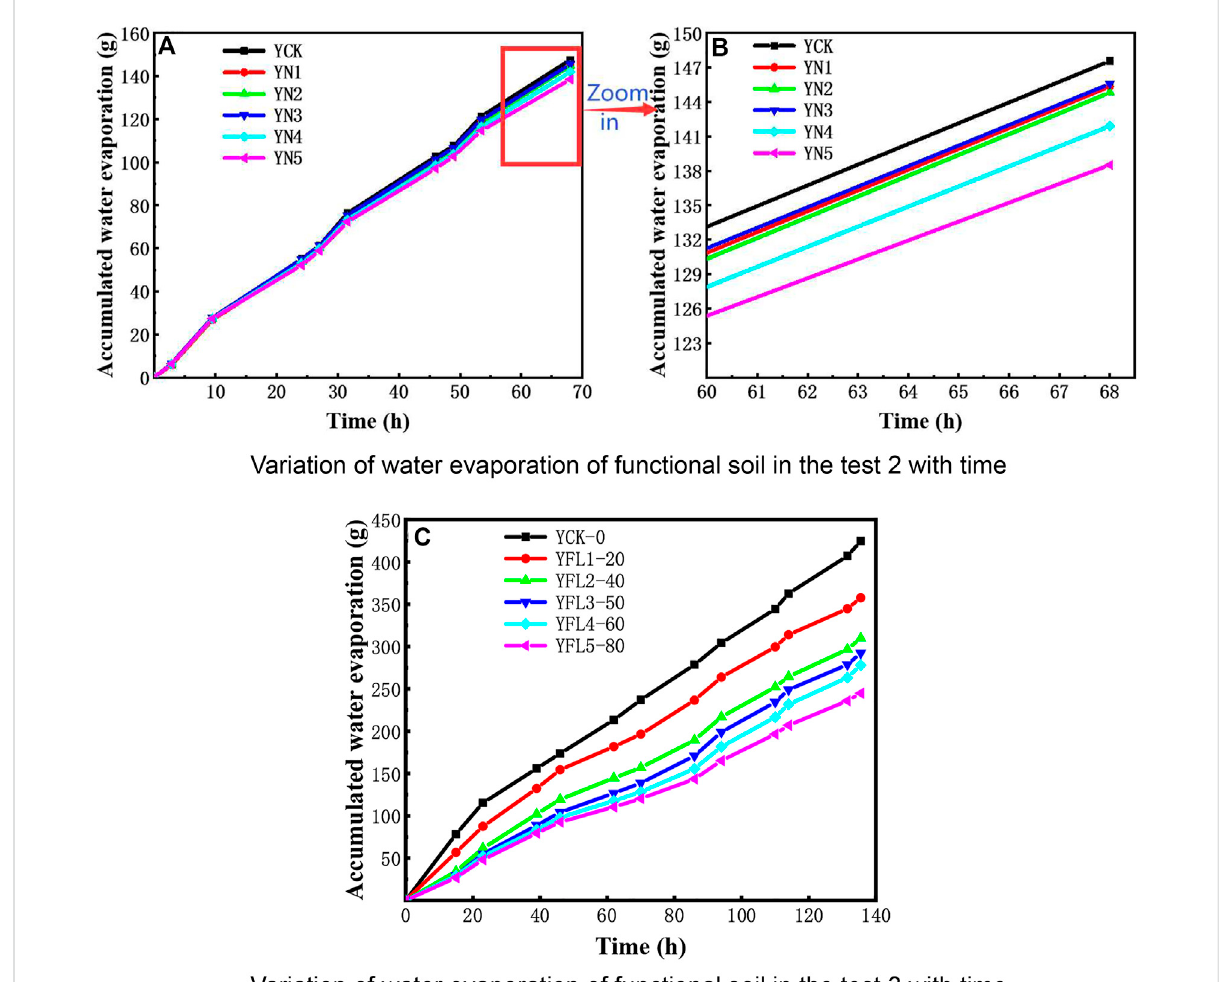
FIGURE 1 Variation of water evaporation of functional soil with